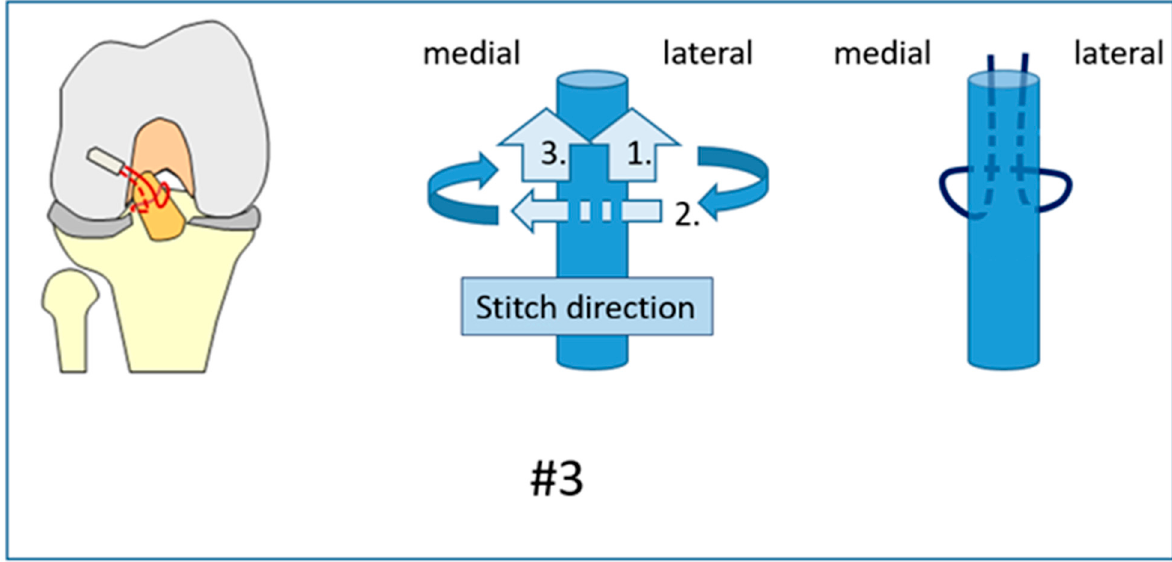
Figure 3. Suture #3 was performed as a modified Kirchmayr [21]